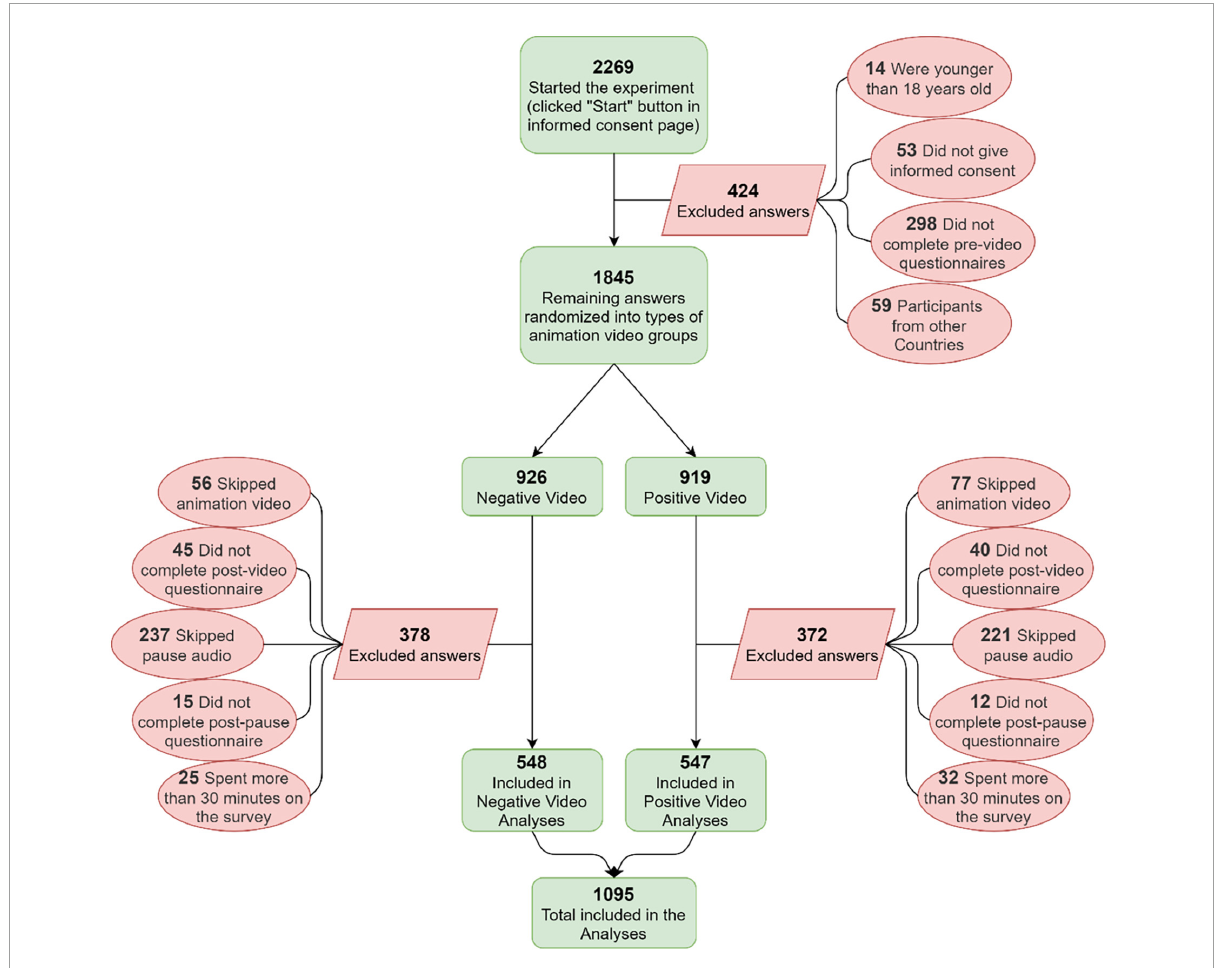
FIGURE1 Study inclusion